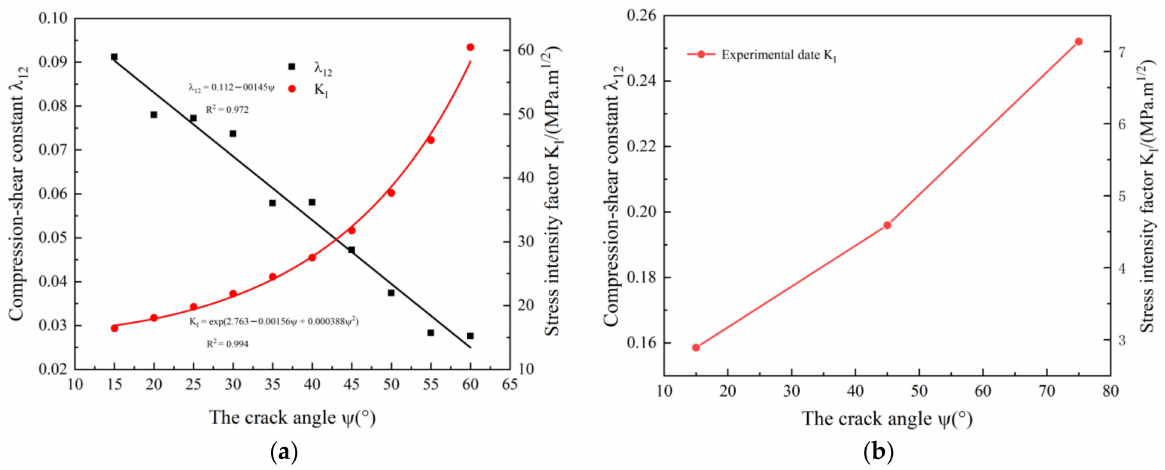
Figure 10. The relationship curves between compression-shear constant, stress intensity factor, and the crack angle. ( a ) Theoretical data; ( b ) experimental data